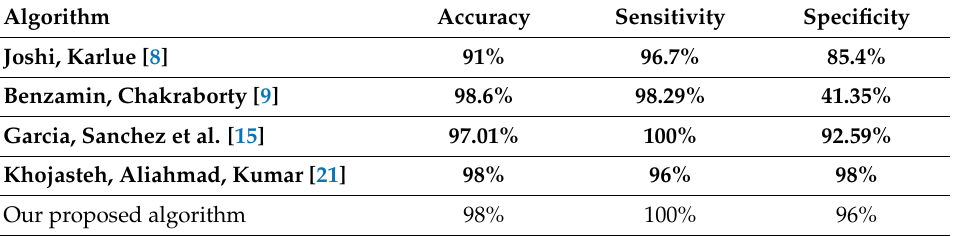
Table 4. Comparison of the proposed solution with different ones described in other works.